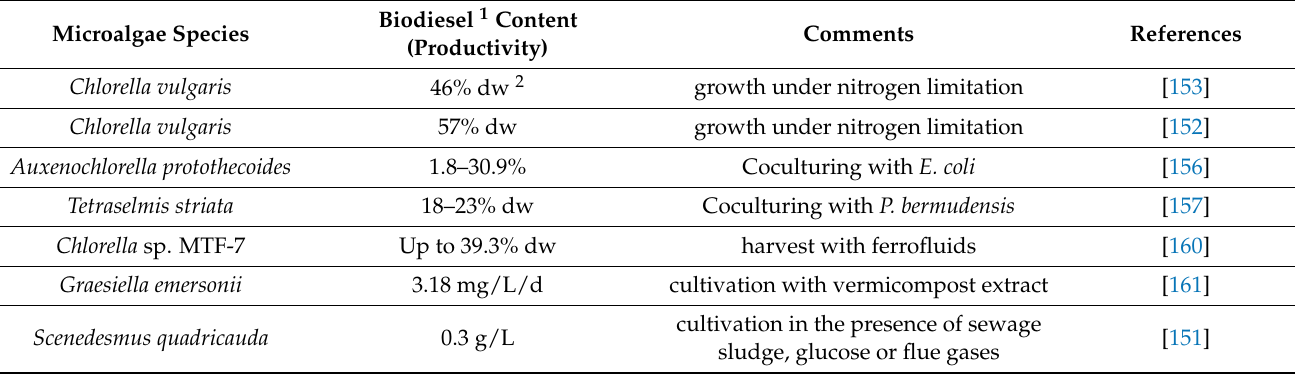
Table 4. Examples of the efficiency of biodiesel production by selected microalgae using different optimization